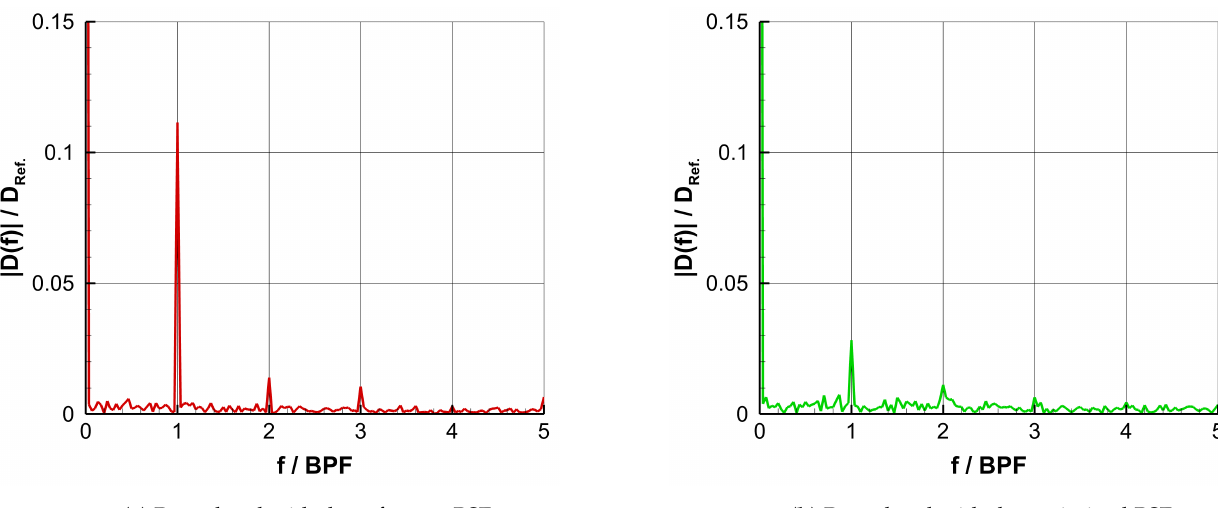
Figure 18. Spectrum of the rotor head drag showing dominant frequencies acting on the rotor